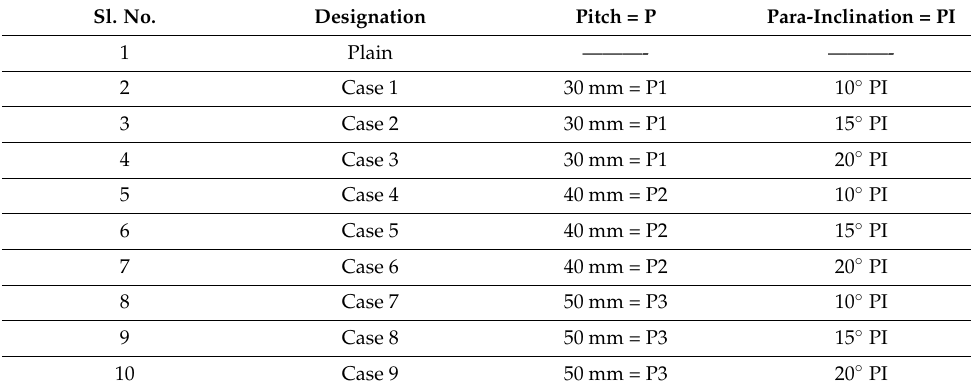
Table 6. Experimental/Numerical case studies.